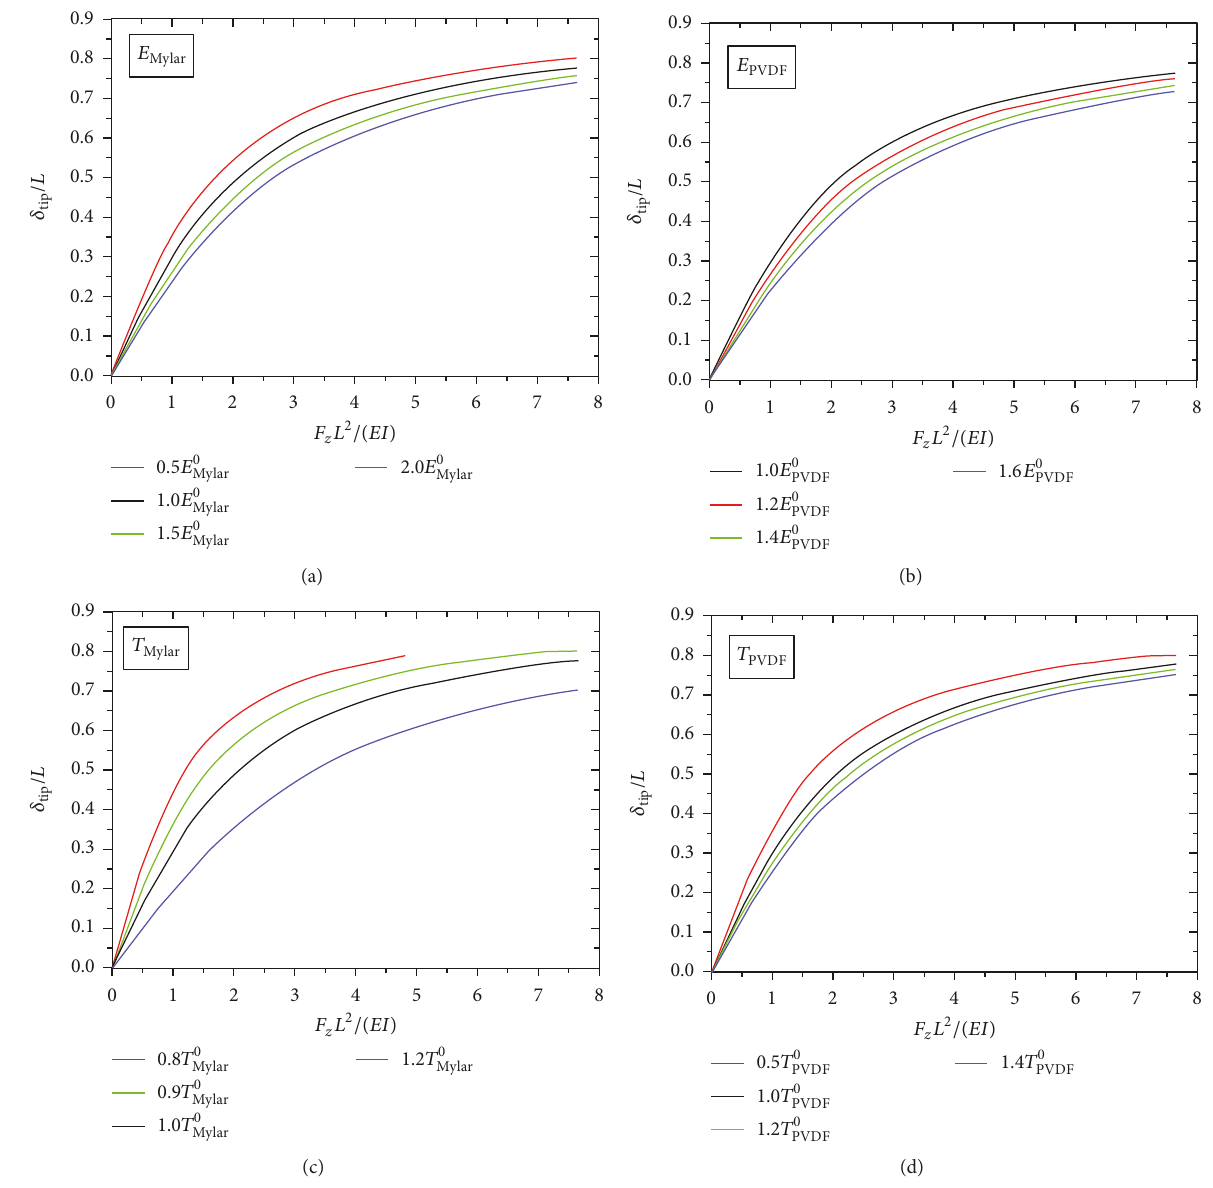
Figure 8: FE-based capacity curves: parametric